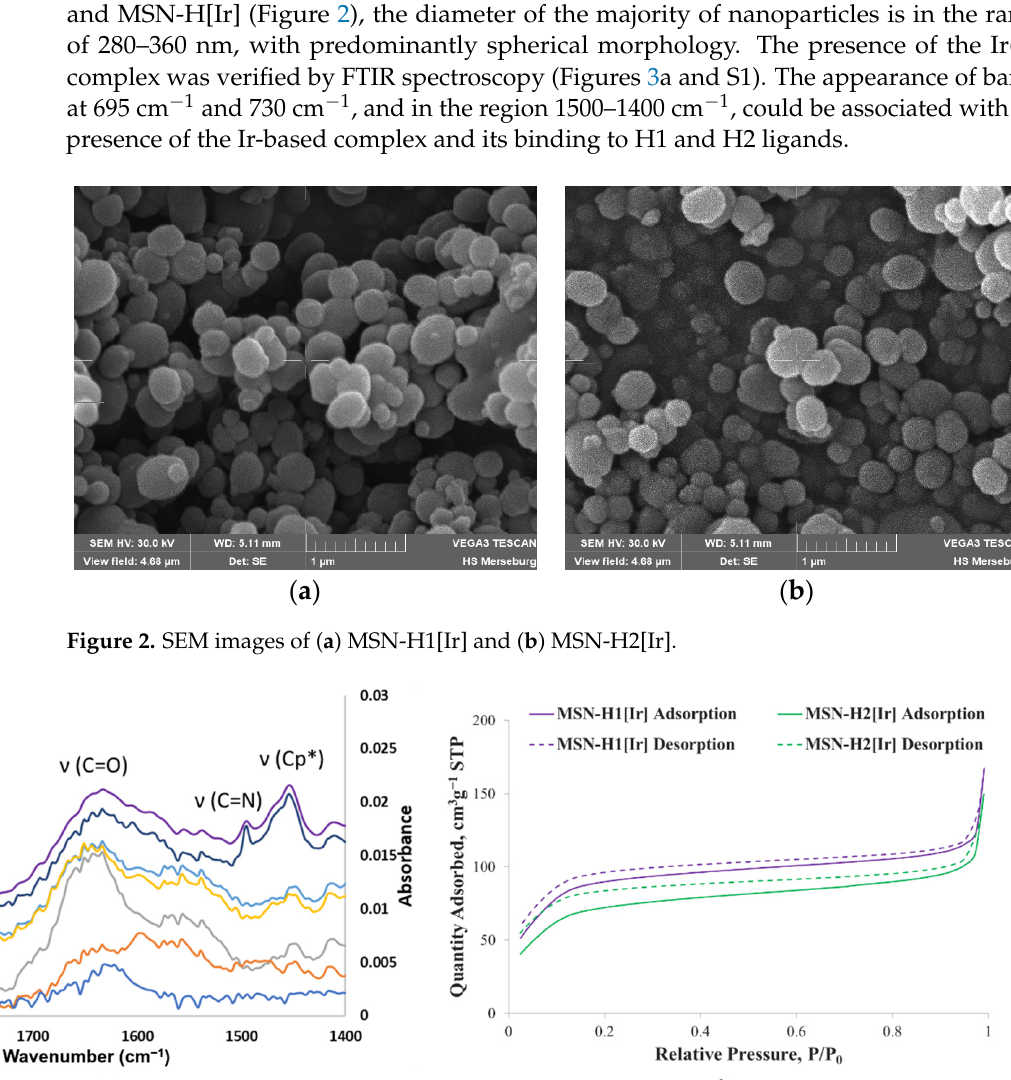
Figure 3. ( a ) FTIR spectra of MSN-H1[Ir] and MSN-H2[Ir] (Cp* = pentamethylcyclopentadienyl), along with the spectra of previously reported precursor materials (MSN, MSN-AP, MSN-PA, MSN-H1,